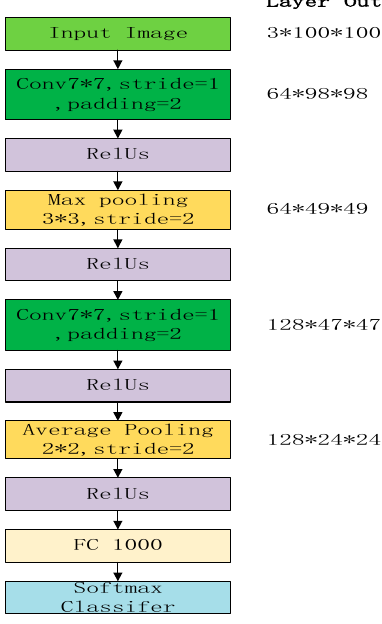
Figure 2. CNN network skeleton.